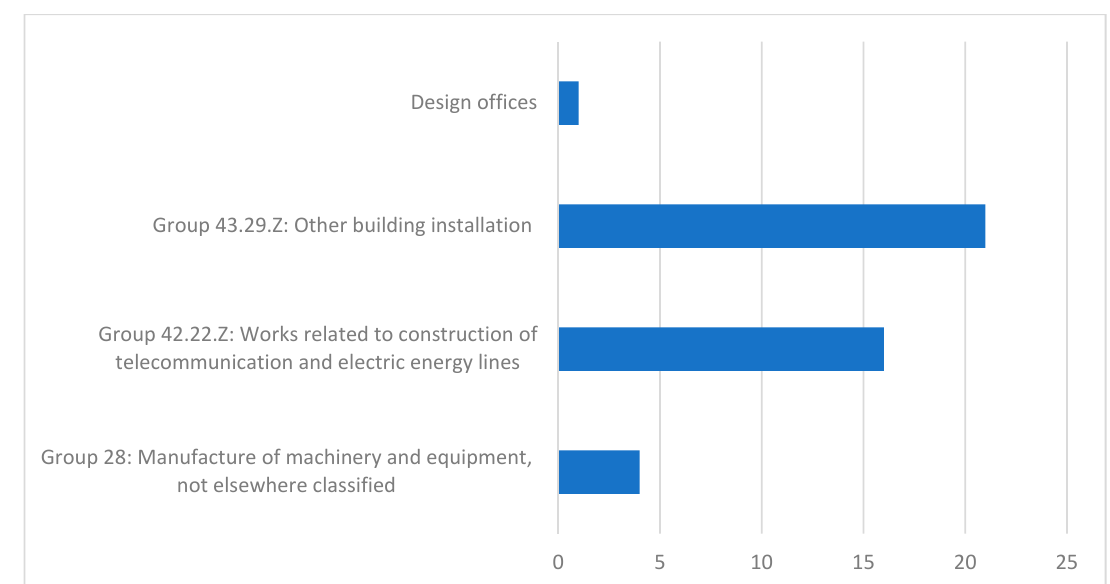
Figure 1. Activity areas of investigated enterprises according to PBC. Source: own elaboration based on own research (multiple choice, sample N = 24).